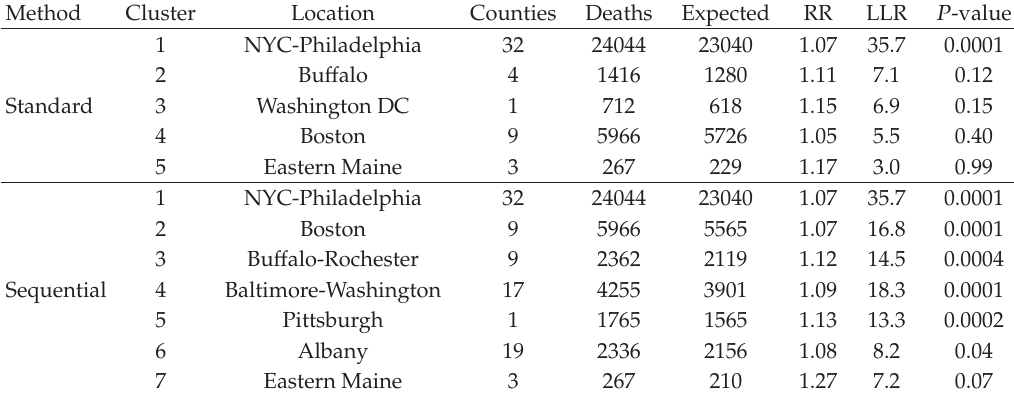
Table 5: Breast cancer mortality analysis for women in the Northeast United States, 1988–1992, using the standard and the sequential spatial scan statistics. RR (cid:7) relative risk within the cluster compared to the rest of the Northeast; LLR: log likelihood